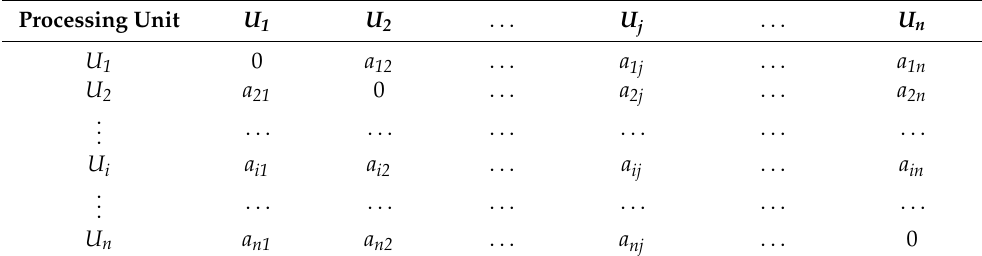
Table 1. The processing sequence relation matrix of all of the processing units.